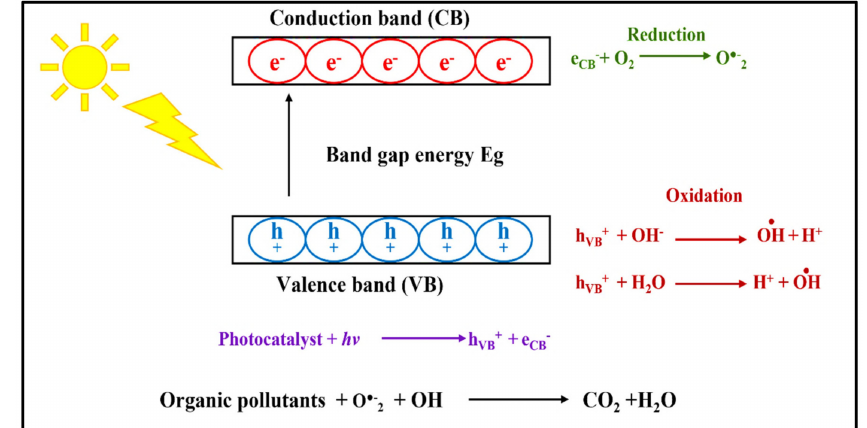
Figure 1. The general mechanism of photocatalytic degradation of organic pollutants in